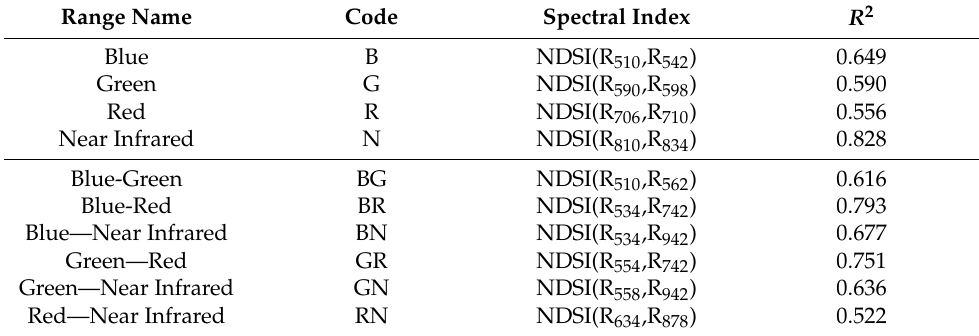
Table 2. Optimum spectral index and its determination coefficient.